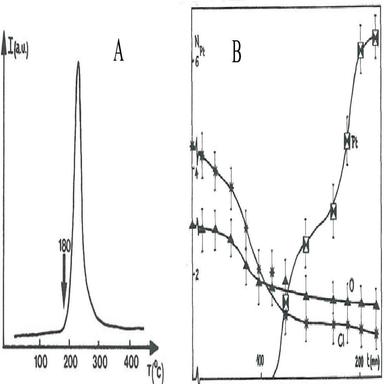
TPR spectrum of Pt/Al2O3 catalyst showing onset of reduction at 180 °C (A). EXAFS CN for Pt-O, Pt-Cl, and Pt-Pt as a function of time during isothermal hold at 180 °C (B). Reprinted with permission from Copyright 1988 The Chemical Institute of Canada.